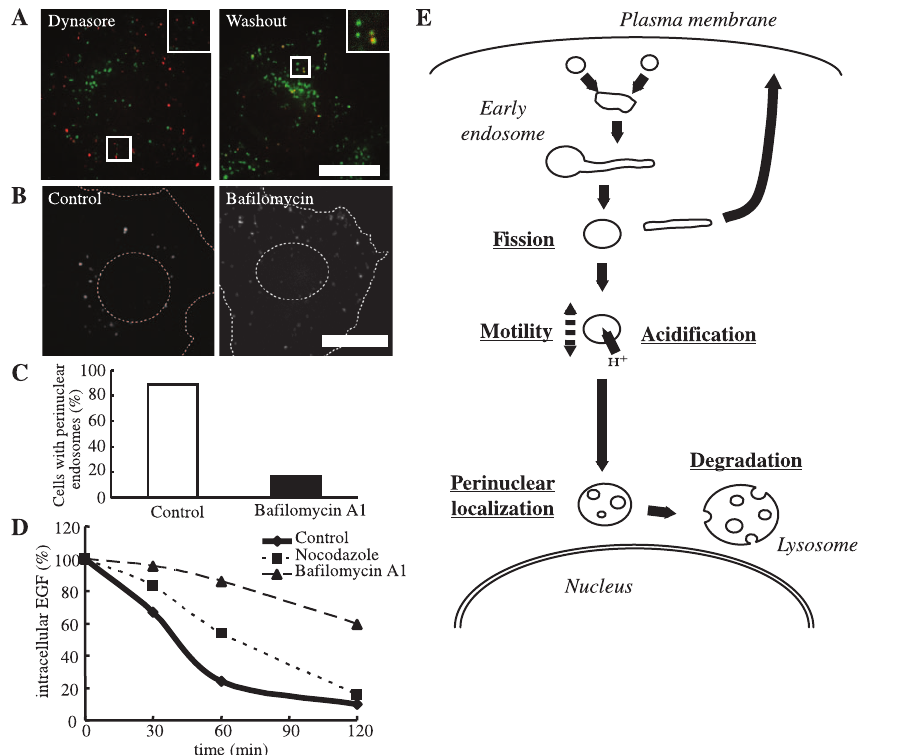
Figure 5. Acidification is required for perinuclear localization of endosomes, and a cascade model of the degradative pathway. A , HeLa cells were bound on ice with Alexa555-EGF, rinsed, and transferred to 37 u C. After 5 min, dynasore was added. For washout, after 30 min the cells were rinsed and incubated in dynasore-free media. Images are just before washout (left) and 10 min after washout (right). B , HeLa cells were incubated with Alexa555-EGF on ice for 1 h, rinsed, and transferred to 37 u C. After 5 min of internalization, DMSO (left) or Baf (right) was added and the cells were further incubated. After 30 min, the cells were fixed. Dashed-line circle, nucleus; Dashed-line (not circle), outline of the cell; Scale bar, 20 m m. C , The endosomes displaying perinuclear localization were manually counted. N=80 cells. D , Cells were incubated with biotin-conjugated EGF on ice for 1 h. After rinsing, the cells were transferred to 37 u C, incubated for the time indicated, and processed by ELISA. Nocodazole was added at 1 hour before the incubation, while bafilomycin A1 was added at 5 min after internalization. E , Both internalized EGF and transferrin initially enter the same early endosomes. EGF is sorted into vacuolar domains and unsorted transferrin is collected into tubules. After tubule fission, intraluminal acidification of EGF-containing endosomes proceeds, as endosomes are motile. As a result, enlarged endosomes are recruited around the nucleus and degradation is finally completed. Dynasore inhibits tubule fission, which blocks the subsequent steps. Bafilomycin A1 inhibits endosomal acidification and causes inhibition of perinuclear localization and degradation, but not of fission or motility. Nocodazole inhibits endosomal motility, resulting in impaired perinuclear recruitment and degradation, but normal endosomal acidification.